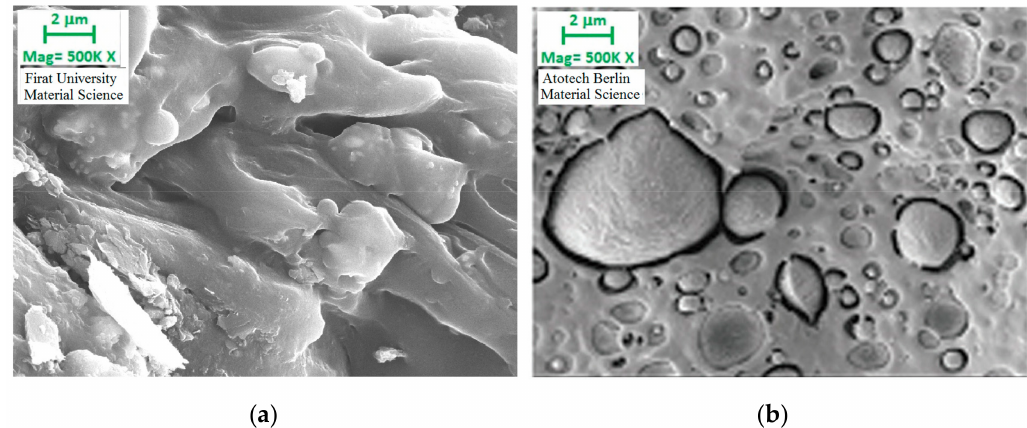
Figure 12. Electron microscope images of 10% filler reinforced polyethylene specimens with ( a ) and without ( b ) gamma